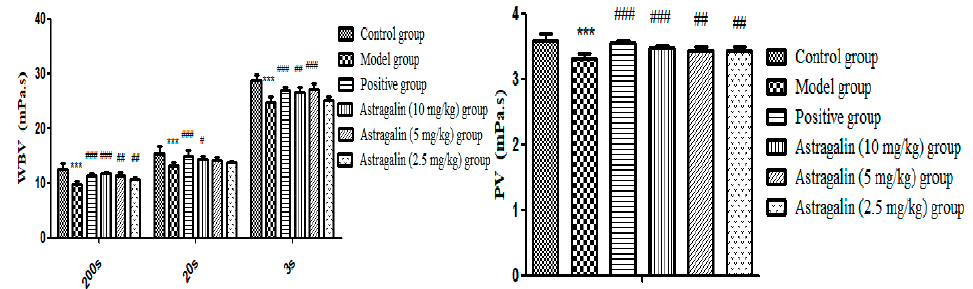
Figure 8. Effects of astragalin on WBV and PV (X ± SD, n = 8). Compared with the control group: *** p